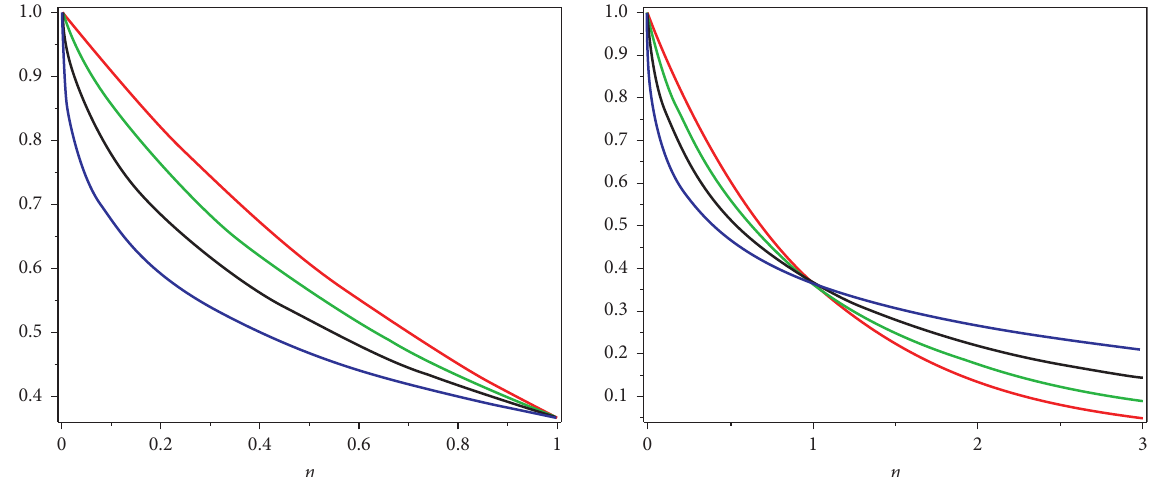
Figure 10: The approximate solution graph of problem 4.3, at different fractional-order of δ with respect to η